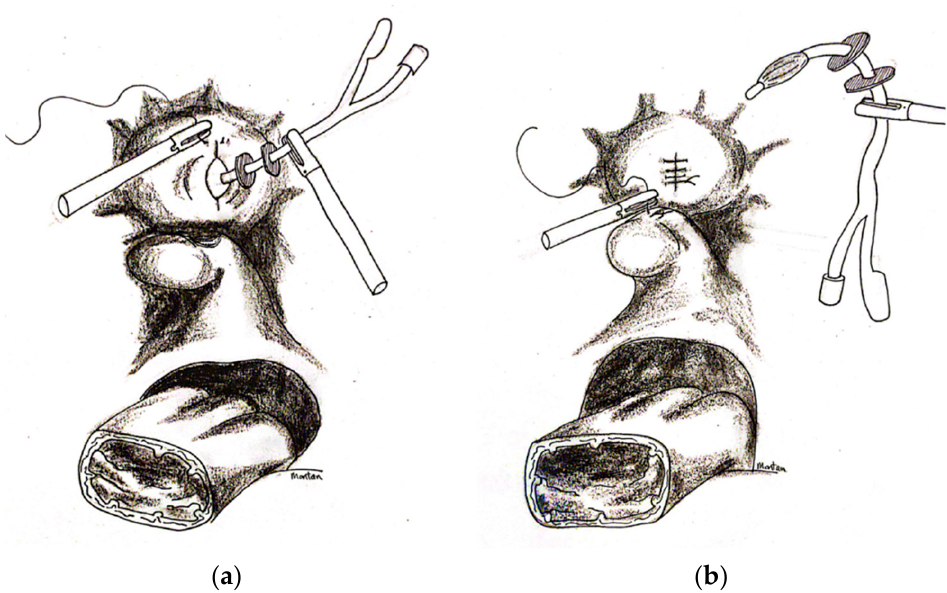
Figure 4. ( a ) Once obtained enough free space distally to the insertion of the catheter in the bladder, a circumferential incision of the vesical part of the VVF around the catheter followed with full resection of the tissue was performed. The bladder was then sutured in two layers helped by traction on the catheter to pinpoint the margins of the hole. ( b ) The bladder was completely sutured after deflation of the Foley. The Foley catheter was removed by deflating the balloon before the first suture was tied. Then, the vagina was sutured with intra-corporeal knots.